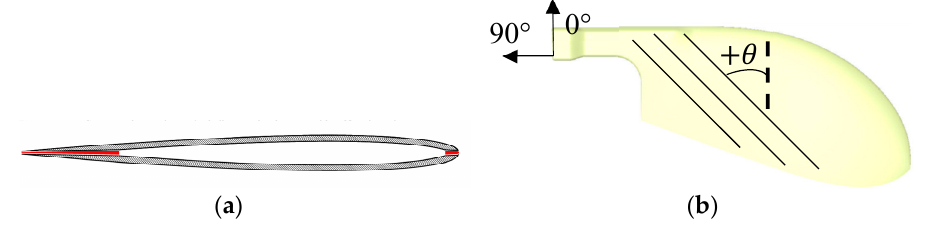
Figure 2. ( a ): Cross-sectional design concept for the rudder blade and ( b ) final rudder design with positive fibre orientation (cid:3397)(cid:2016)°